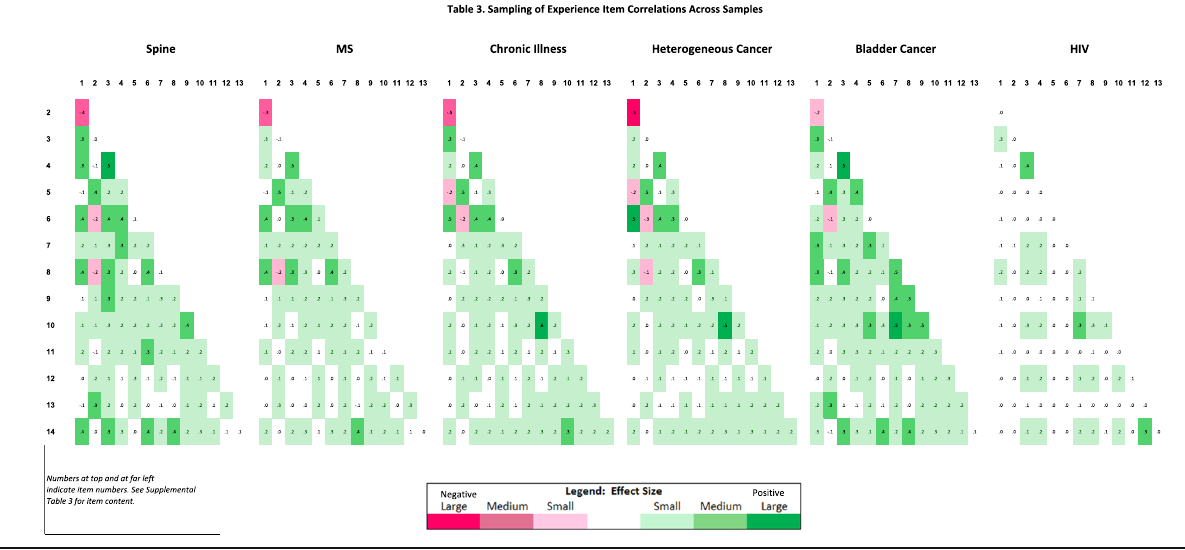
Table 3 Sampling of Experience item correlations across